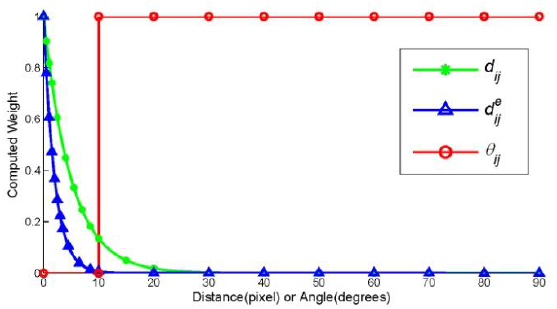
Fig. 5 Independent weight curves for each measure. The control parameters ( σ 1 and σ 2 ) are (5 and 2),